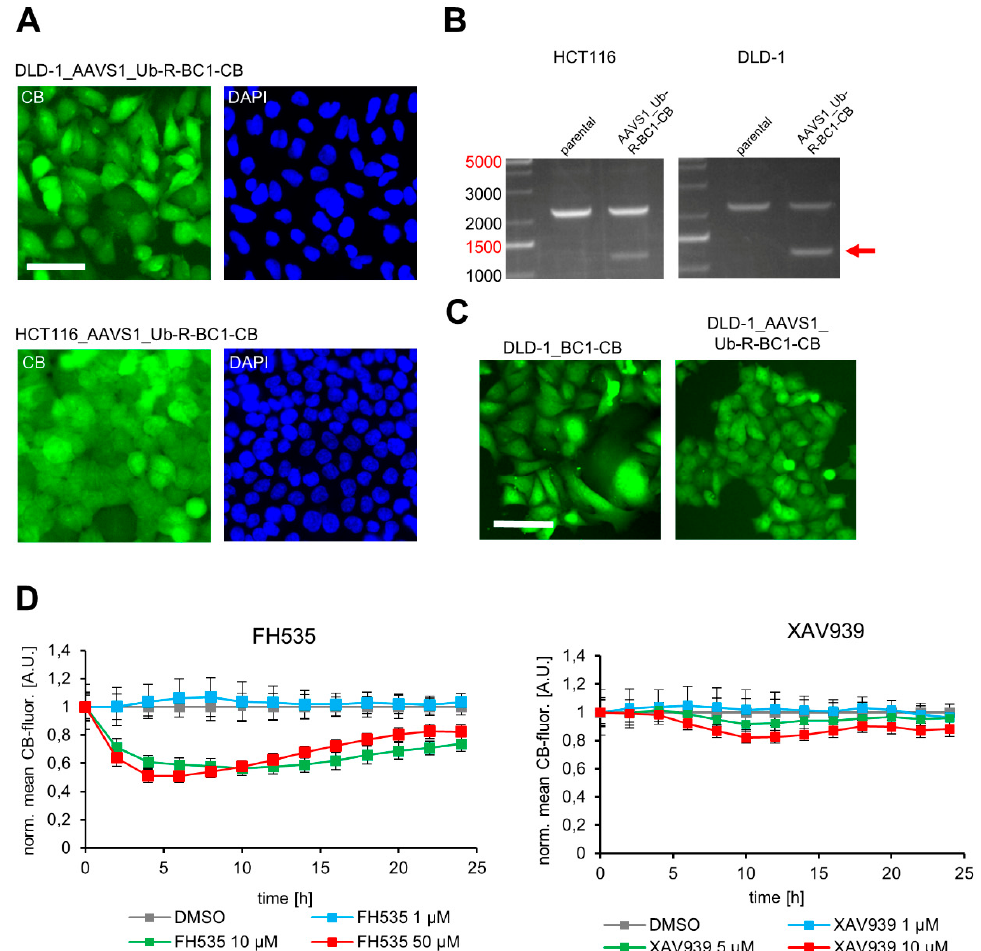
Figure 6. Generation of colorectal carcinoma cell lines with stable AAVS1 integration of the turnover-accelerated Ub-R-BC1-CB encoding transgene. ( A ) Representative fluorescence images of isolated DLD-1 (upper panel) and HCT116 (lower panel) clones stably expressing Ub-R-BC1-CB. Nuclei were stained with DAPI, scale bar: 50 µ m. ( B ) Genotyping of HCT116_AAVS1_Ub-R-BC1-CB and DLD-1_AAVS1_Ub-R-BC1-CB. Genomic DNA of host cells was extracted and subjected to PCR using the